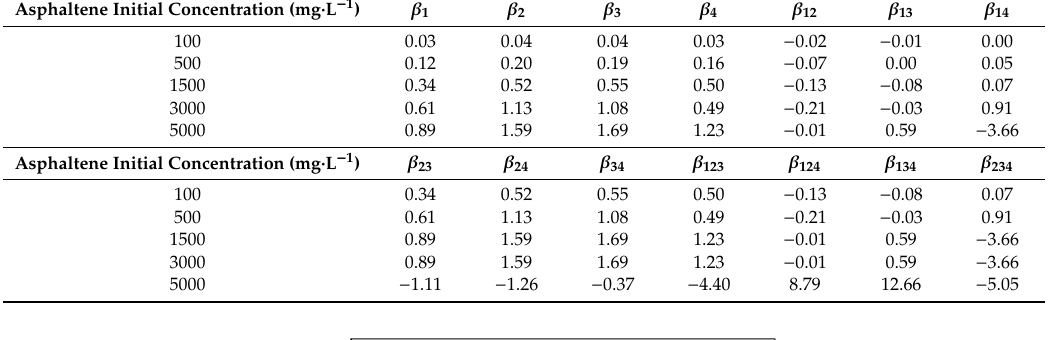
Table 7. Coe ffi cients of the Special Cubic Model for the Si-Fe-Ni-Mo mixture.